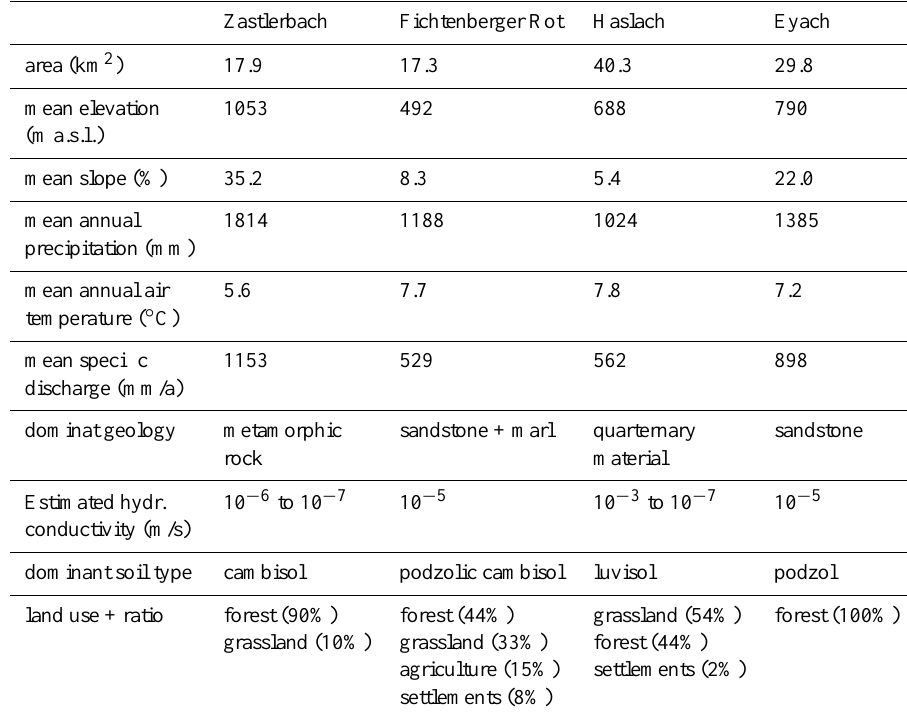
Table 3. Watershed